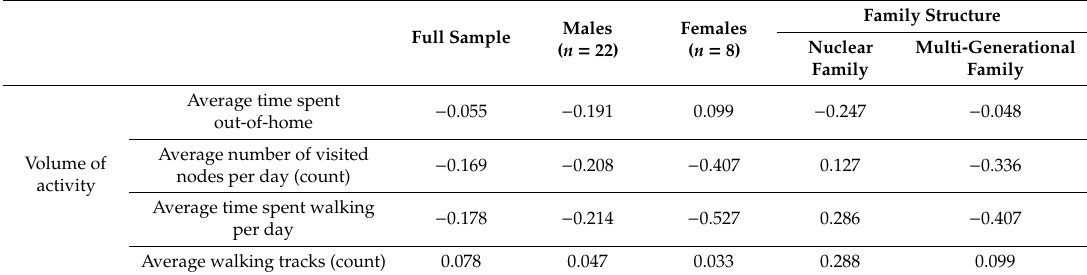
Table 4. Bivariate Correlations (Spearman correlations) between reported life satisfaction and spatial activity measures.